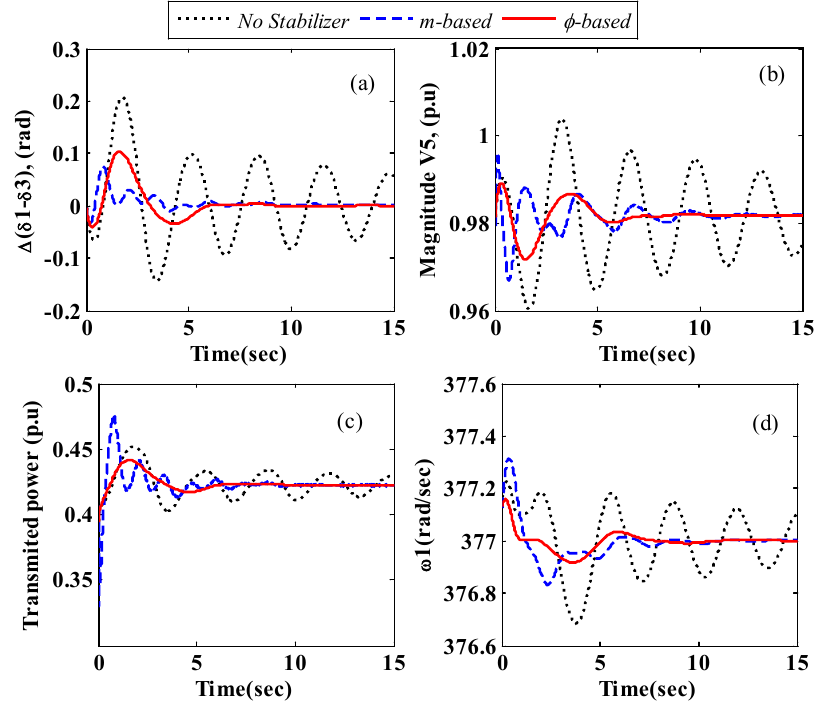
Figure 14. Nonlinear simulations in normal loading using a robust-based stabilizer designed by the hGWO-GA algorithm (( a ) angle difference between G 1 and G 3 , ( b ) magnitude of voltage bus 5, and ( c ) transmitted power between area1 and area2, ( d ) rotor speed of generator G1).